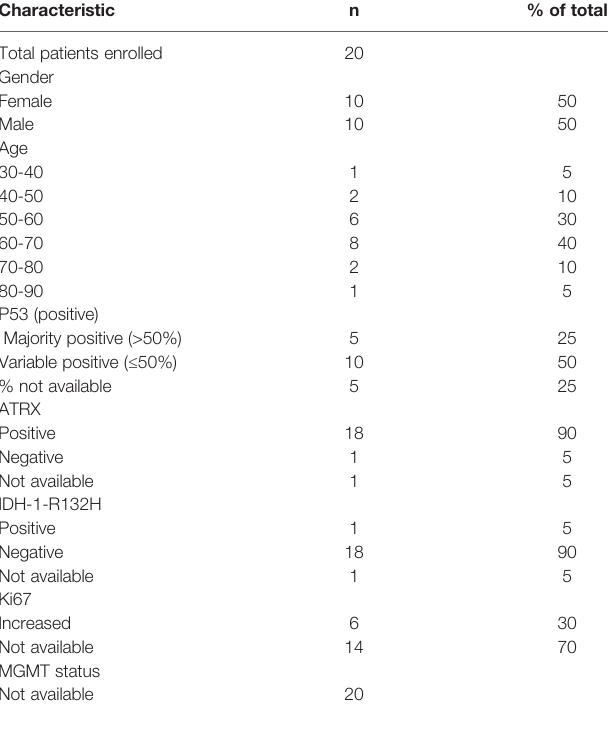
TABLE 1 | Demographic and clinical information of GBM patients.